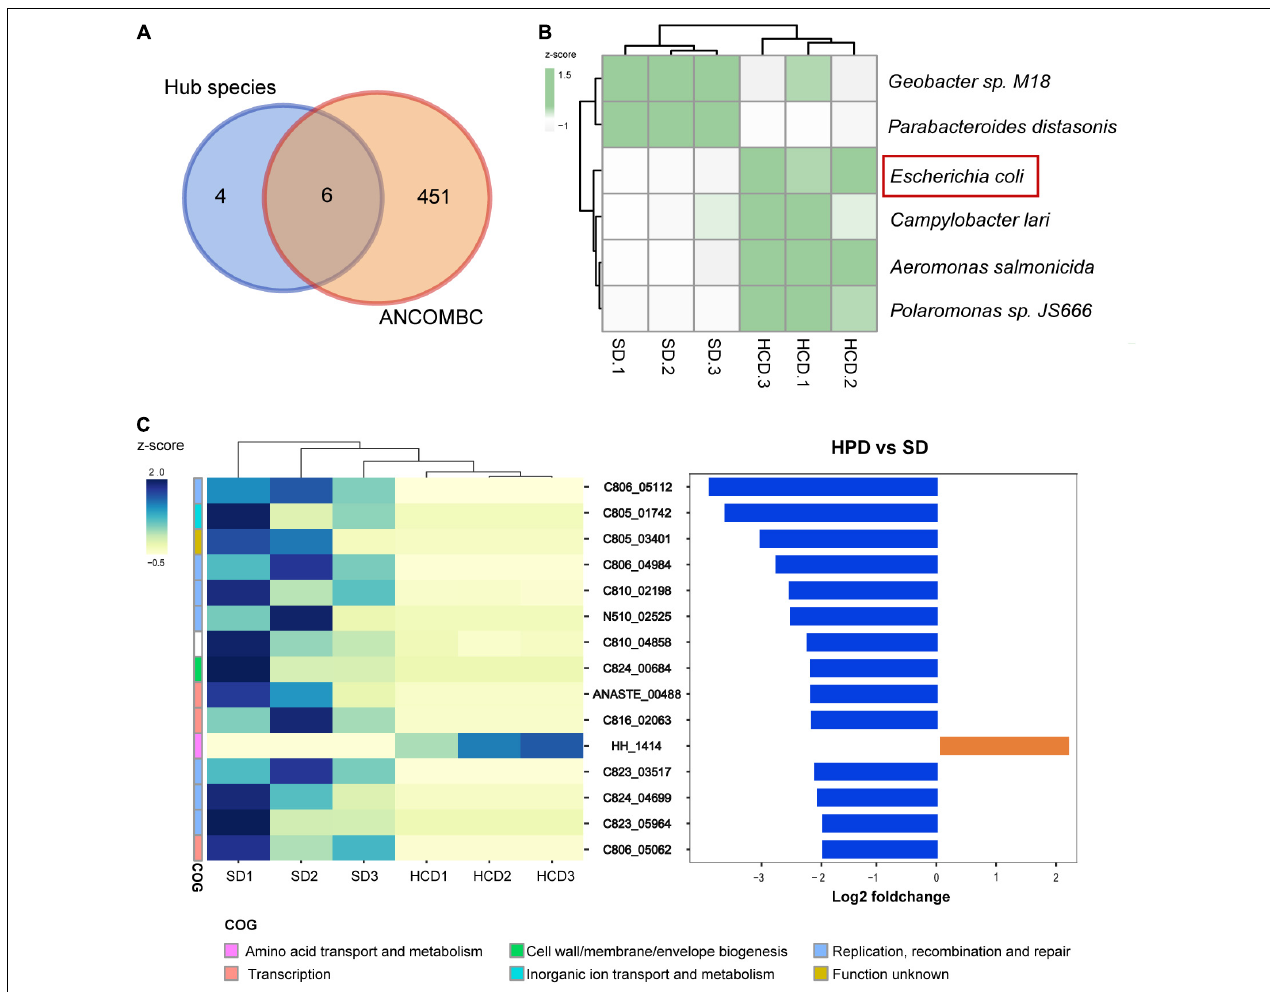
FIGURE 3 | Gut microbiota and OGs with significantly different abundance under high protein diet. (A) Venn diagram shows the number of shared and unique species for the hub species and ANCOMBC. (B) The heatmap graph shows the relative abundance of six taxa detected in Figure A. The colors from white to green represent the degree of difference. (C) There are 15 OGs detected with the threshold value [Mann–Whitney rank test, P < 0.05, | log2FC| > 2]. They demonstrate functional genetic alterations in intestinal microbes with high-protein diet